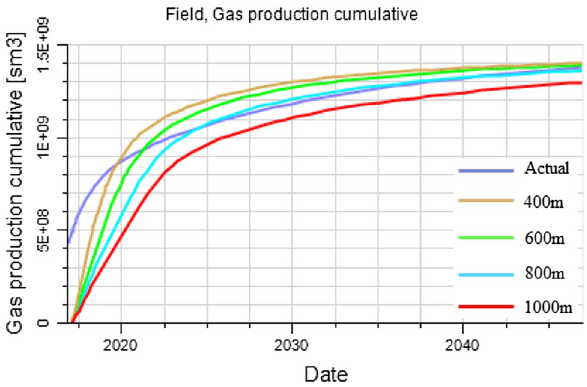
Fig. 9 Demonstration of well space—the cumulative gas production curve of the sweet spot